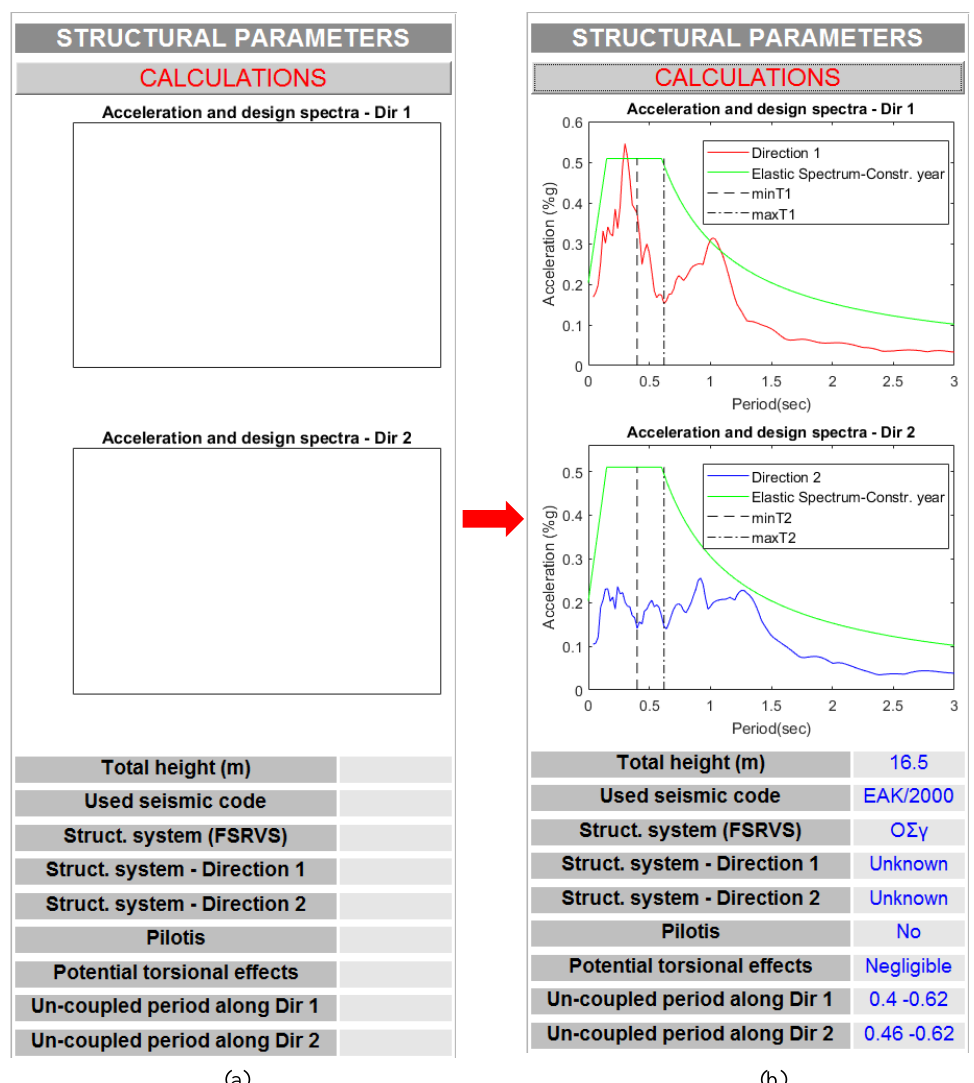
Figure 9. The window used for the presentation of the structural parameters ( a ) before and ( b ) after running.